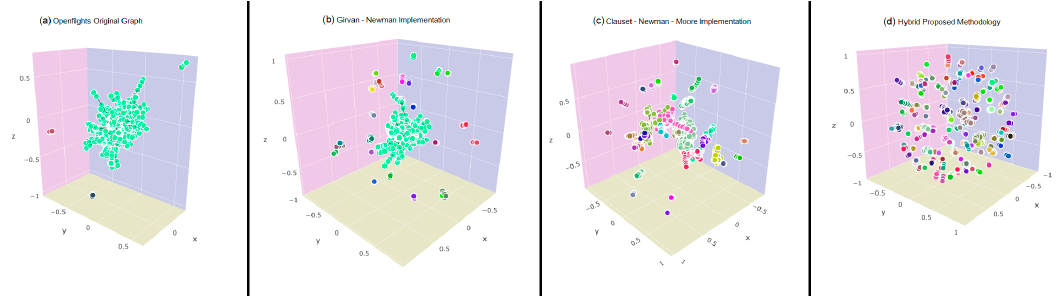
Figure 3. The graphical comparison of the different generated community structures for the Openflights information network per each method applied: ( a ) The Openflights original graph visualization; ( b ) the Girvan–Newman generated community structure; ( c ) the Clauset–Newman–Moore generated community structure; and ( d ) the hybrid proposed methodology returned community structure.